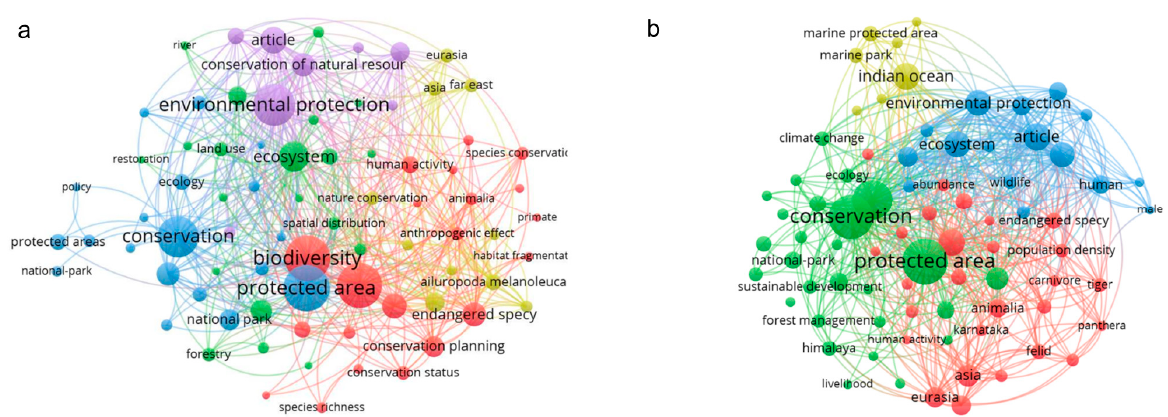
Figure 4. Timeline visualization of institute co-authorship networks for CPAP ( a ) and IPAP ( b ).